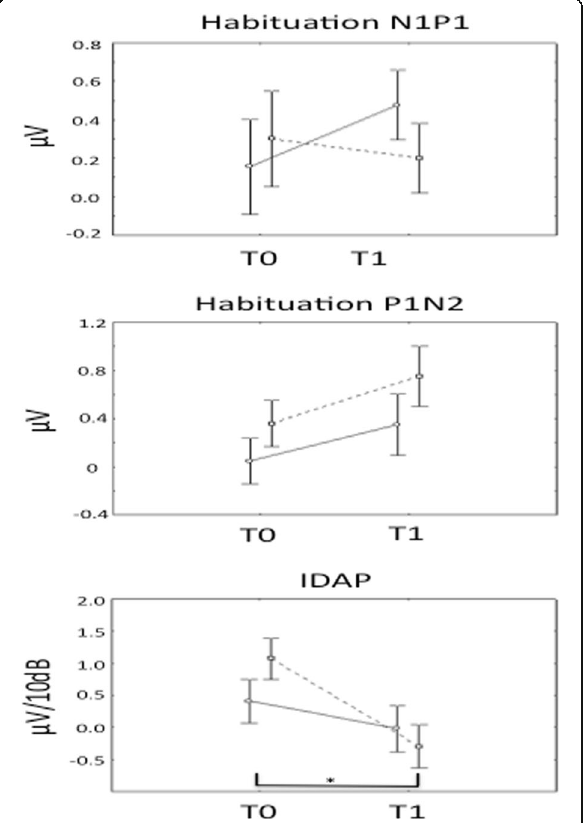
Fig. 3 Responders vs. No-responders difference in early neurophysiological responses after GON-B. One week after the GON-B responders had no change in N1P1 response. For P1N2 component of habituation both Responders and Non-responders had a trend towards the reduction of habituation degree (although not significant, p =0.11). No significant difference was found after multiple comparison tests. On the other hand, CM patients had an early reduction in IDAP slope, corresponding to an increase in serotonin firing, after GON-B ( p =0.008), with a